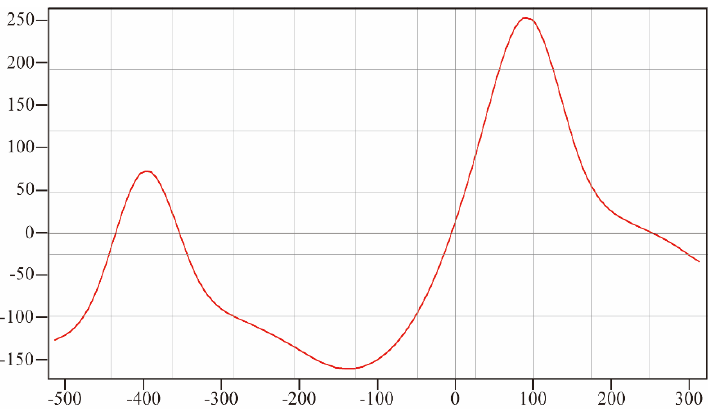
Figure 3. Operational relationship between the basic functions.